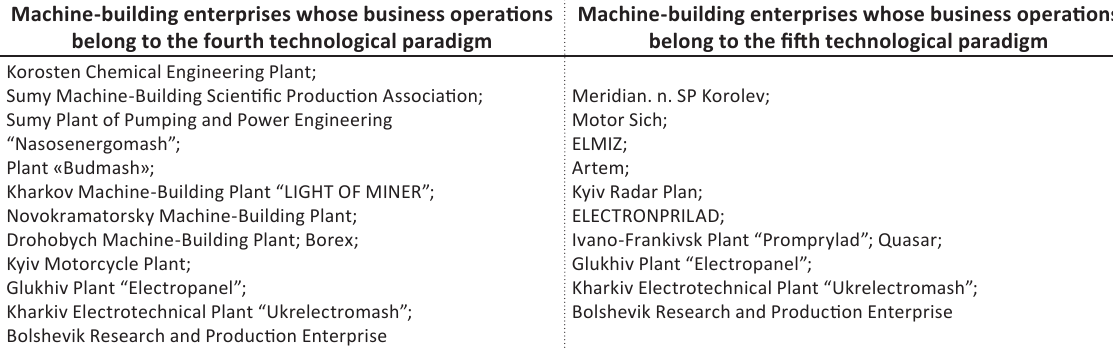
Table A1. Ukrainian machine-building enterprises under study Machine-building enterprises whose business operations Machine-building enterprises whose business